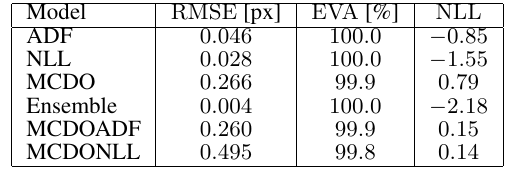
Table 1. Results on the test data of the basic dataset. Higher values for RMSE and EVA and lower values for NLL indicate better results.